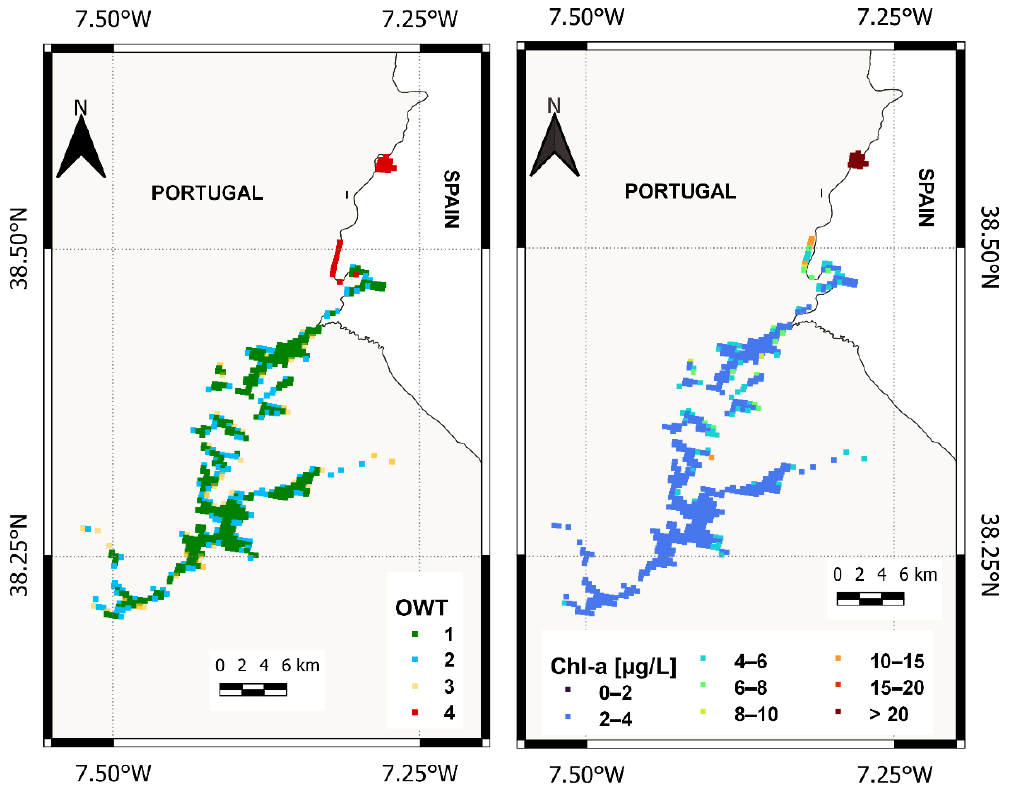
Figure 16. OWT ( left ) and Chl-a ( right ) maps on 23 July 2017 in the Alqueva reservoir.